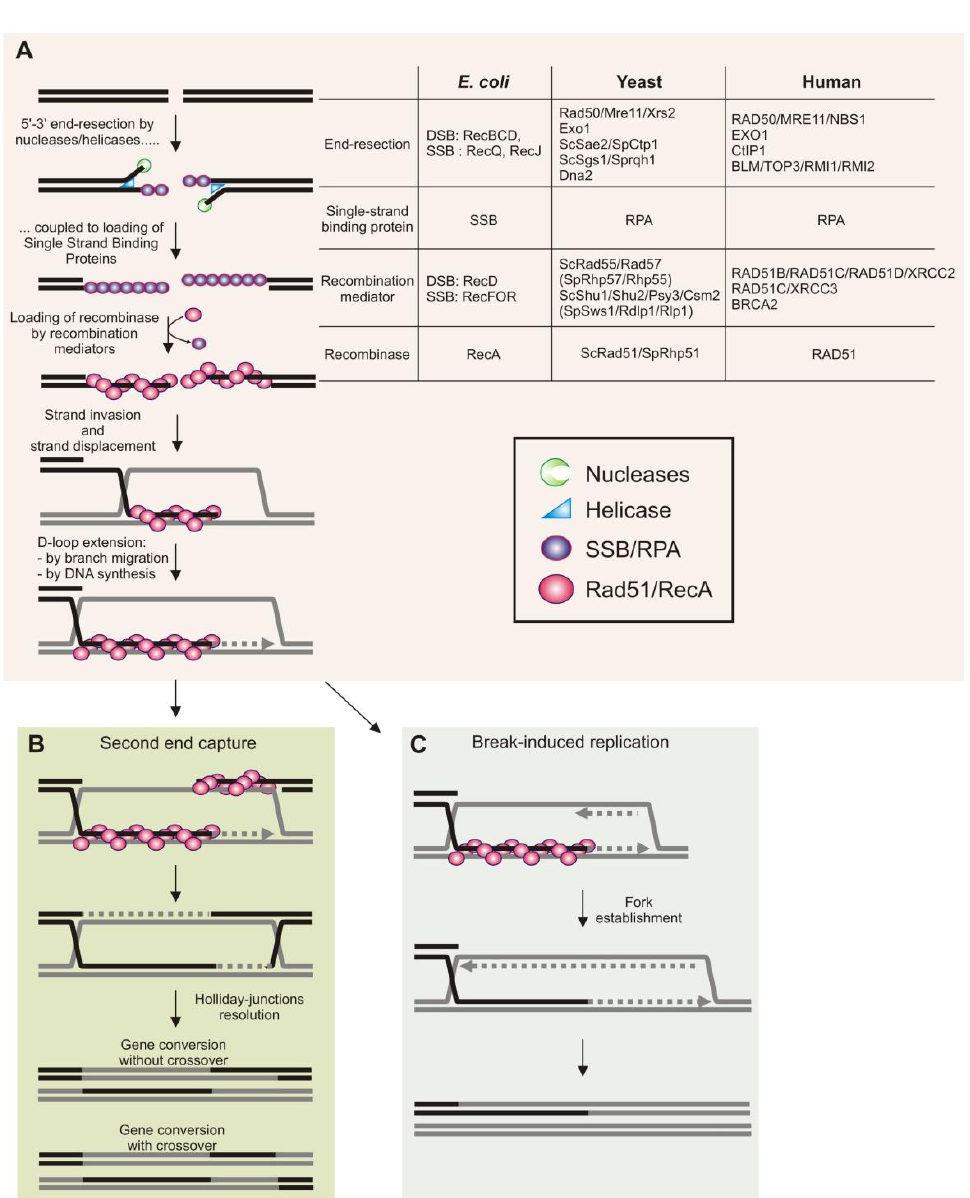
Figure 1. Early Steps of Homologous recombination during double-strand break repair (see text for details). ( A ) Single-Stranded Binding proteins are loaded onto 3'-overhanging single-stranded DNA (ssDNA) resulting from 5'-3' end resection by the concerted action of nucleases and helicases. Recombination mediator proteins help the recombinase Rad51 to nucleate on ssDNA and to form a structured nucleoprotein filament. Recombinases then promote the invasion of the 3' single-stranded end into a DNA duplex, to pair it with the complementary strand, and to displace the non-complementary strand. The resulting three-stranded structure is termed displacement loop (D-loop). The 3' end of the invading strand primes DNA synthesis to copy the DNA template. ( B ) The second extremity of the DSB is captured by annealing of the displaced strand, leading to the formation of double Holliday junctions (dHJs). Repair of the DSB is completed by the resolution of dHJs to form recombinant products that are associated, or not associated, with crossovers (COs, reciprocal exchange of genetic information). ( C ) Model of break-induced replication that can lead to establishment of a replication